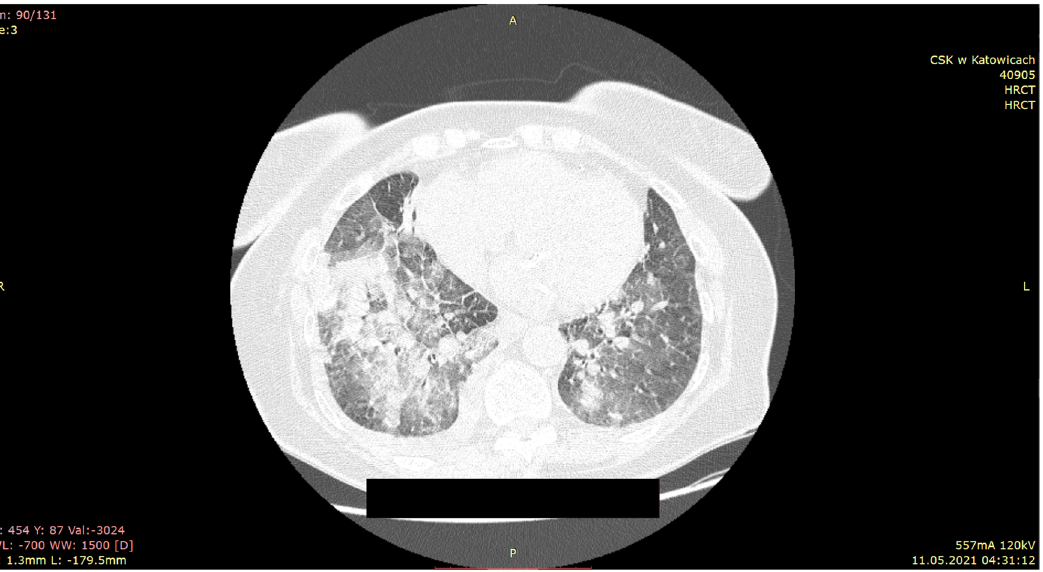
Figure 1: HRCT scans on hospital admission: bilateral, superimposed air space consolidations with GGO in lower and upper lobes, more marked on right are